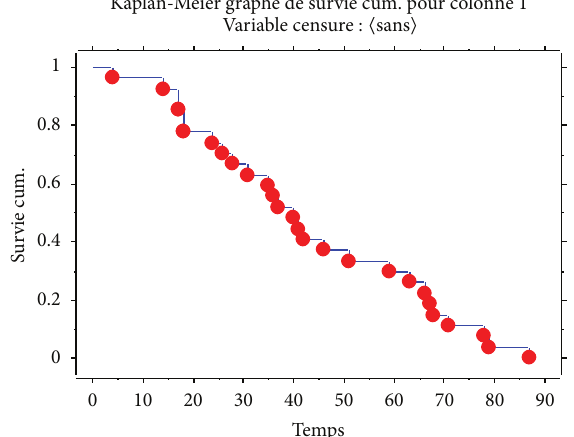
Figure 1: Curve of overall survival in CML patients with additional cytogenetic abnormalities.